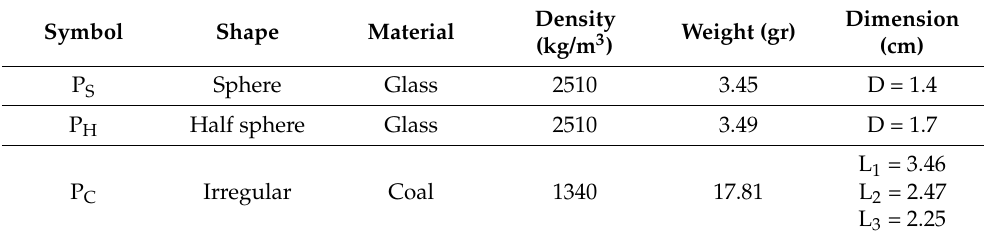
Table 1. Parameters of the investigated particles.